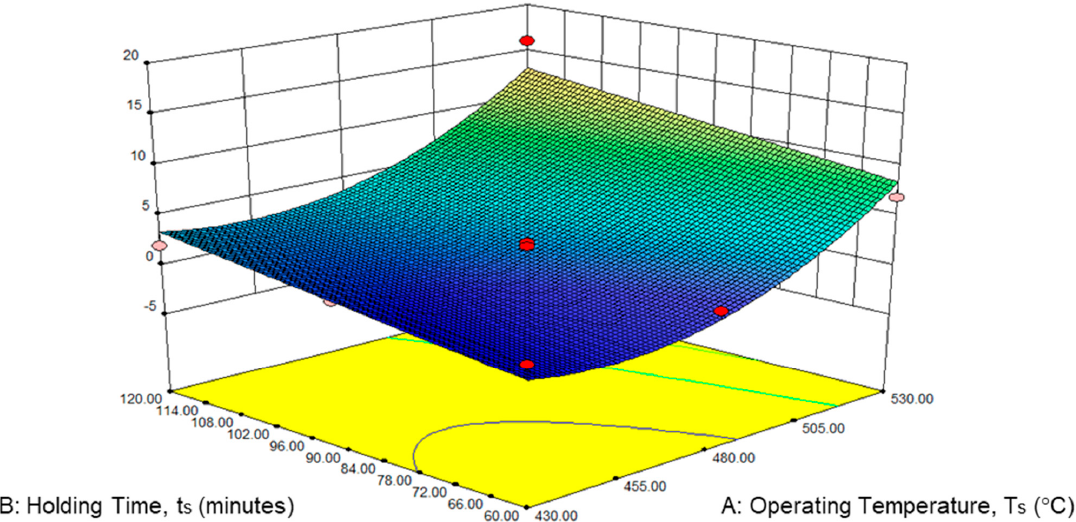
Figure 6. E ff ect of the ( A ) operating temperature and ( B ) holding time on elongation to failure, ETF.